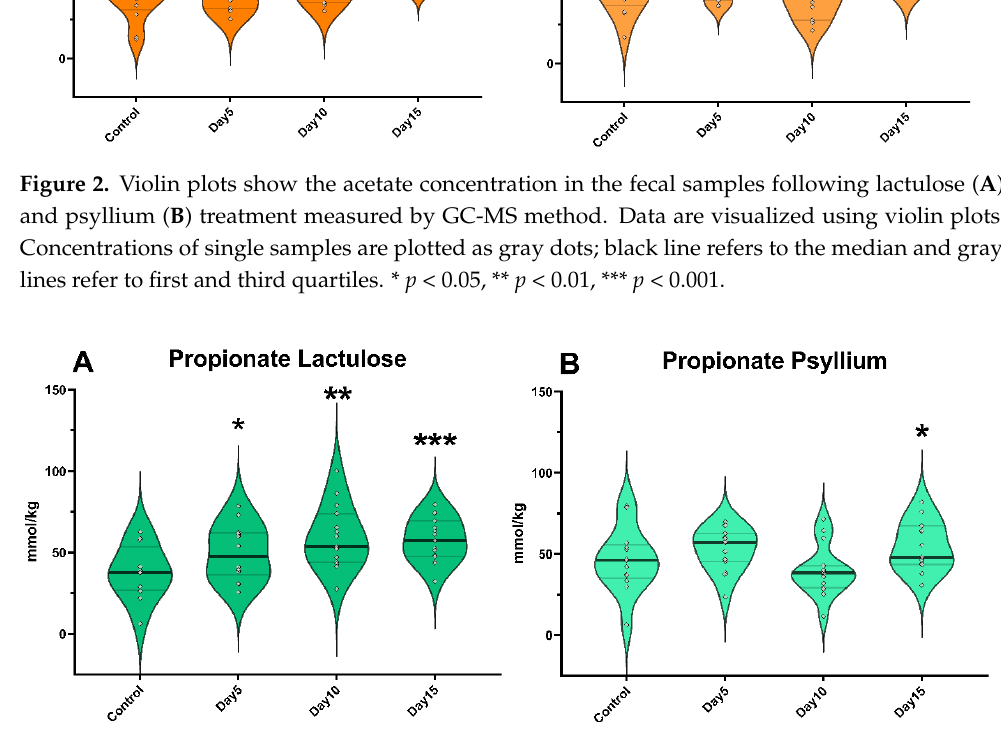
Figure 2. Violin plots show the acetate concentration in the fecal samples following lactulose ( A ) and psyllium ( B ) treatment measured by GC-MS method. Data are visualized using violin plots. Concentrations of single samples are plotted as gray dots; black line refers to the median and gray lines refer to first and third quartiles. * p < 0.05, ** p < 0.01, *** p < 0.001. The amount of propionate was significantly higher ( p = 0.041) following lactulose ad-